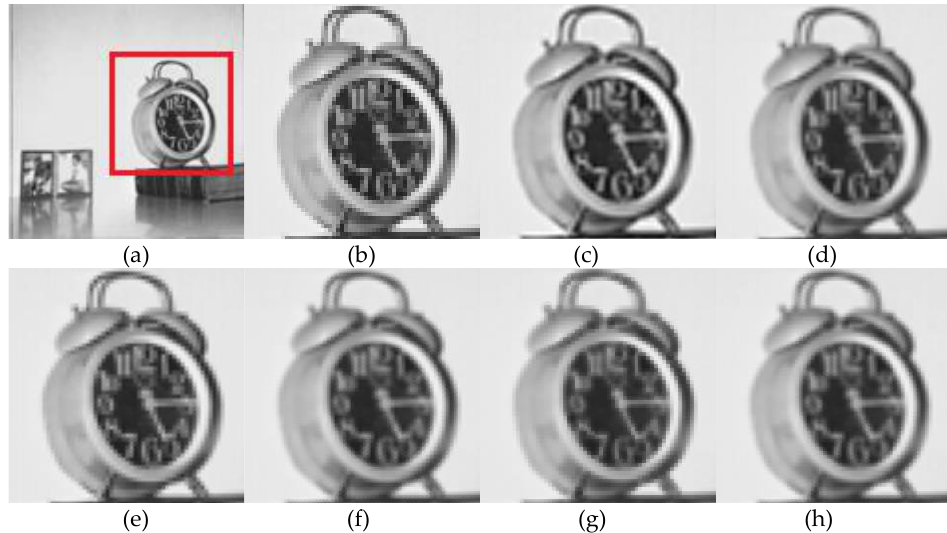
Figure 15. ( a ) Clock test image inside a red square: ( b ) traditional nearest neighbor (TN), ( c ) traditional bicubic (TC), ( d ) traditional bilinear (TB), ( e ) normalized minimum side-based diameter-based (MD), ( f ) normalized hypotenuse radius-based (HR), ( g ) normalized virtual pixel length-based height for the area of the triangle-based (AT), and ( h ) normalized virtual pixel length for hypotenuse-based radius for the area of the circle (AC) interpolation